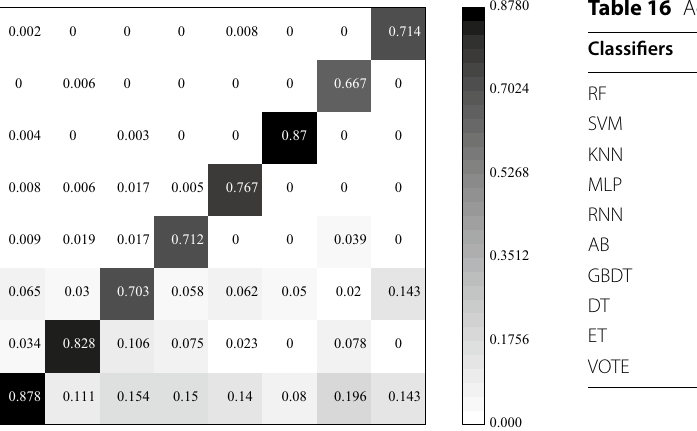
Fig. 10 The confusion matrix of RF